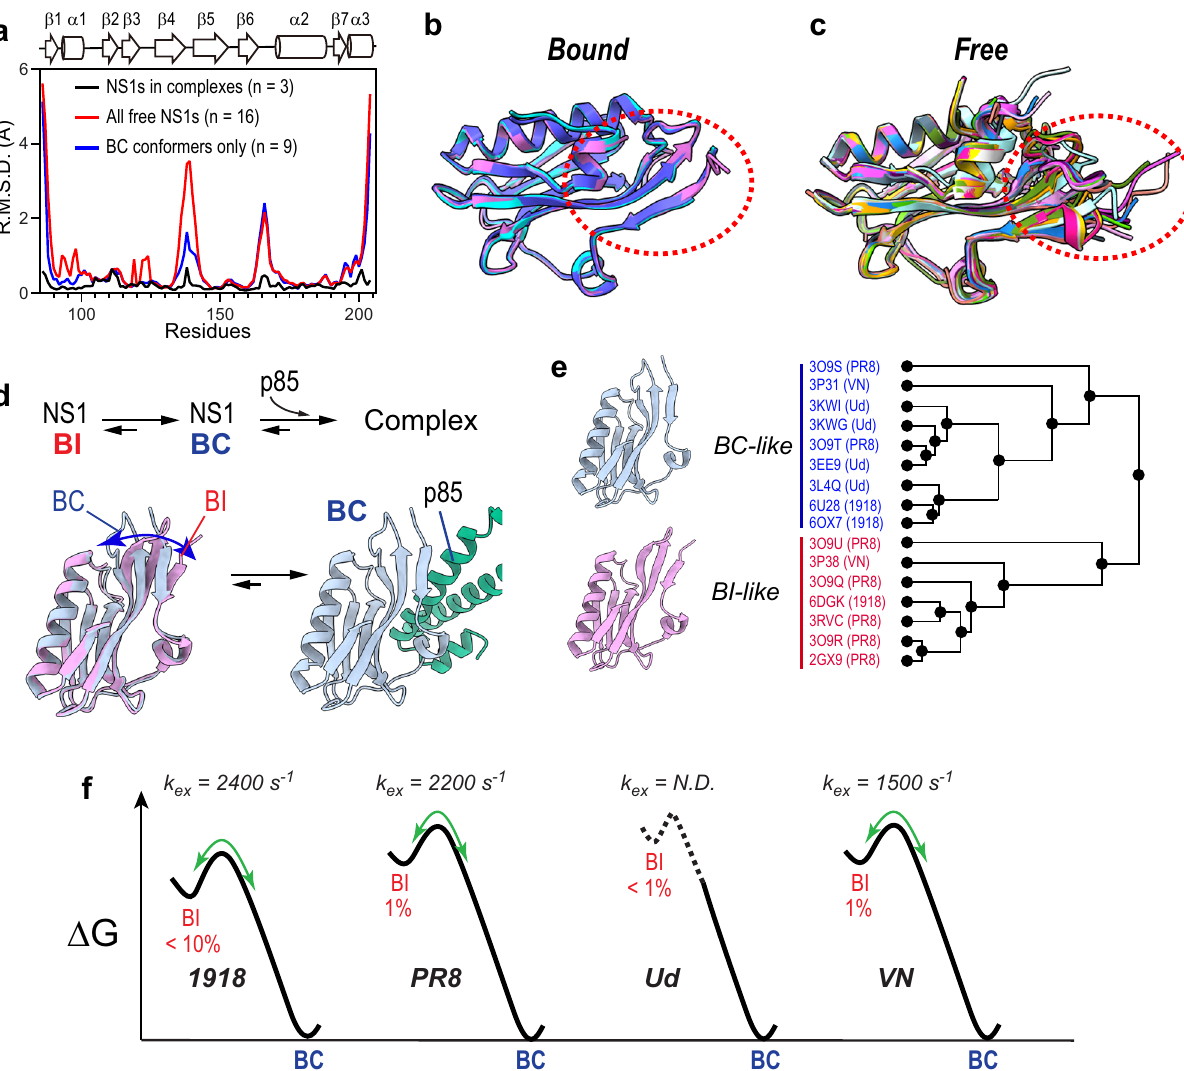
Fig. 4 | Conformational energy landscape of NS1. a RMSD ( n =4) of backbone Cartesian coordinates of NS1s. Source data are provided as a Source data fi le. See panel e for PDB IDs of NS1 structures included in the calculation. b Superimposed structures of 1918 (cyan), PR8 (orchid), and VN (slate blue) in complex with p85 β . The structure of p85 β is not shown for clarity. c Superimposed structures of free NS1s ( n =13) from 1918, PR8, Ud, and VN strains. The conformationally most het- erogeneous region is marked with a red dotted circle. d Schematic showing the